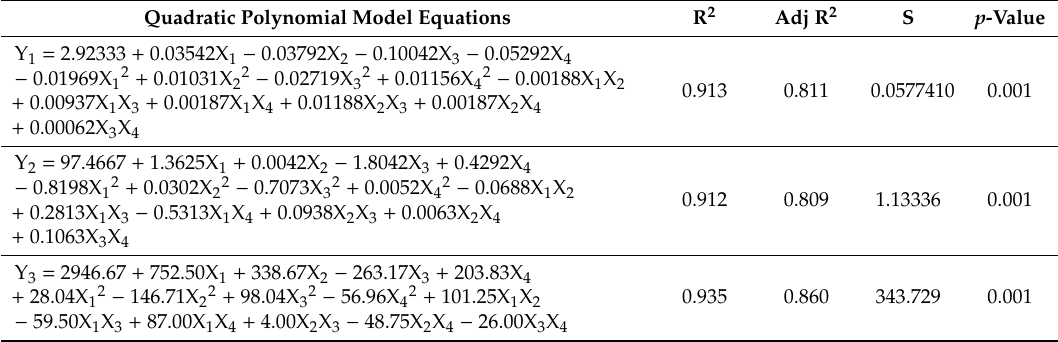
Table 4. The response surface model equations for monitoring the e ff ects of preparation conditions on the physical properties.